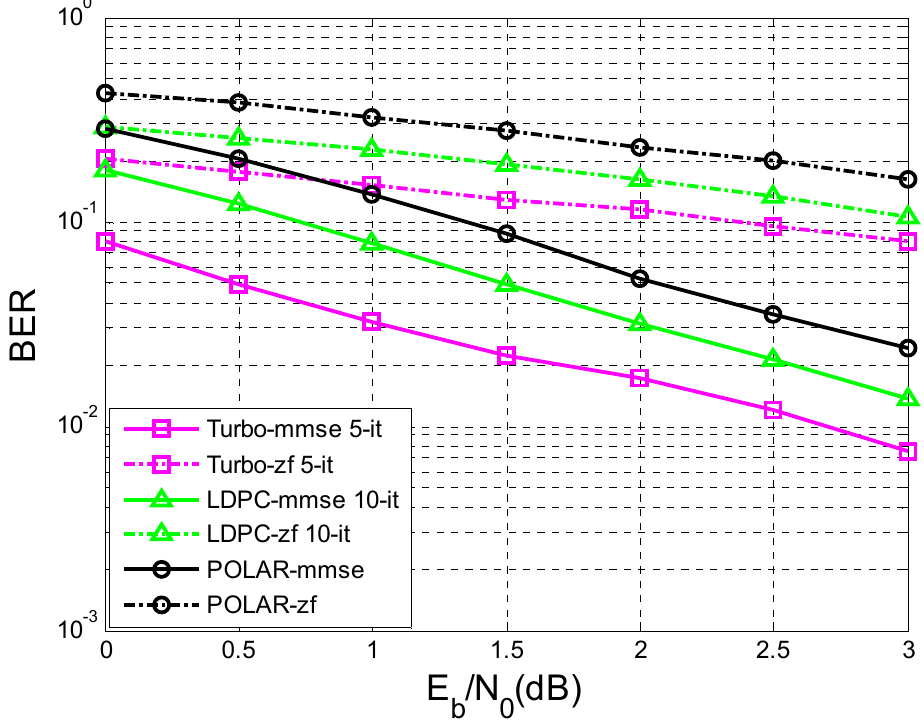
Figure 13. BER vs. SNR for different codes in the case of MMSE and ZF equalization applying LS estimation (K = 342 bits h = (0.18 0.85 0.32), N =